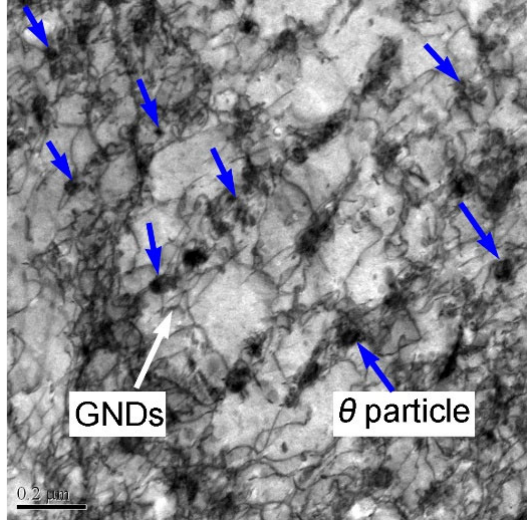
Figure 10. TEM morphology of α + θ phase in the specimen Cryo–R–550–30 after yield. The intragranular θ particles could prevent the dislocation movement and then store large amount of dislocation, helping to improve the yield strength and work hardening, while the intergranular θ particles with relatively large size took up the positions of the fractional grain boundaries, decreasing the accumulation capacity of dislocation at the grain boundaries and further impairing the strength of the grain boundaries. In addition, the dislocation loop formed at the dislocation intersection with the θ particles led to a strain gradient around the θ particles, which was beneficial to the work hardening. Therefore, the poorer work hardening of specimen Cryo–R–550–30 could be explained by the relatively greater amount of intergranular θ particles with large size. Moreover, the low tensile strength in specimen Cryo–R–550–30 was also related to the presence of relatively more intergranular θ particles, which reduced the strength of the grain boundaries and the yield